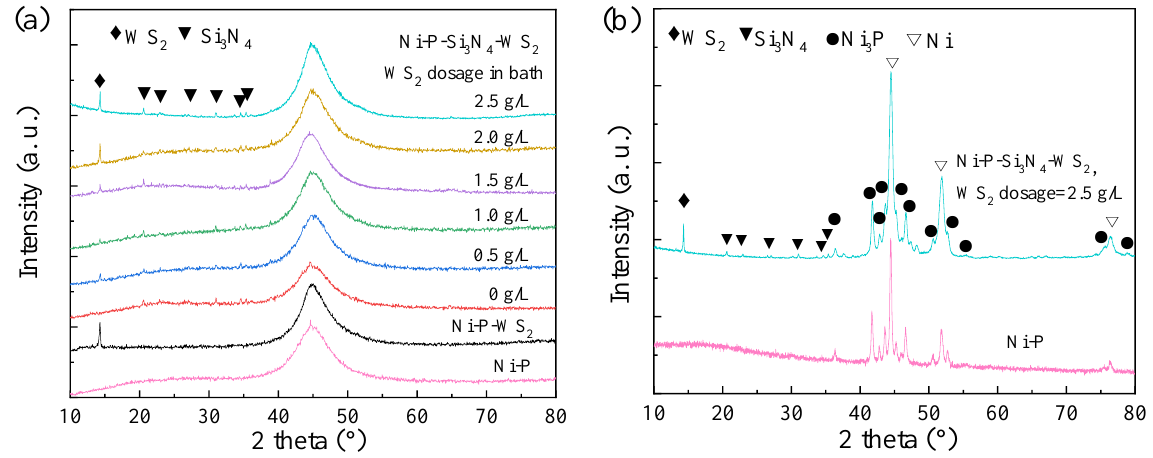
Figure 3. XRD patterns of Ni-P based coatings with various WS 2 dosages in bath: ( a ) as-plated; ( b ) annealed.